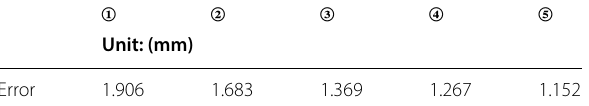
Simulation In this section, numerical simulations of grasping an object and its orientation control are conducted using a newly redesigned virtual object frame. The object grasp- ing and manipulation controller use the virtual frame, which was proposed by Tahara et al. [16], is an externally